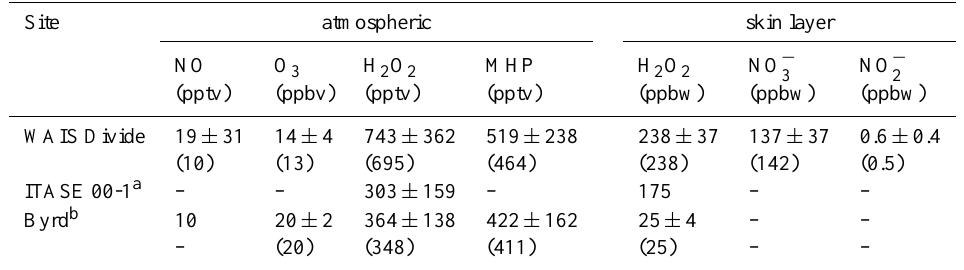
Table 1. Averages ± 1 σ (medians) of atmospheric and snow concentrations of the chemical species observed at WAIS Divide and nearby sites.